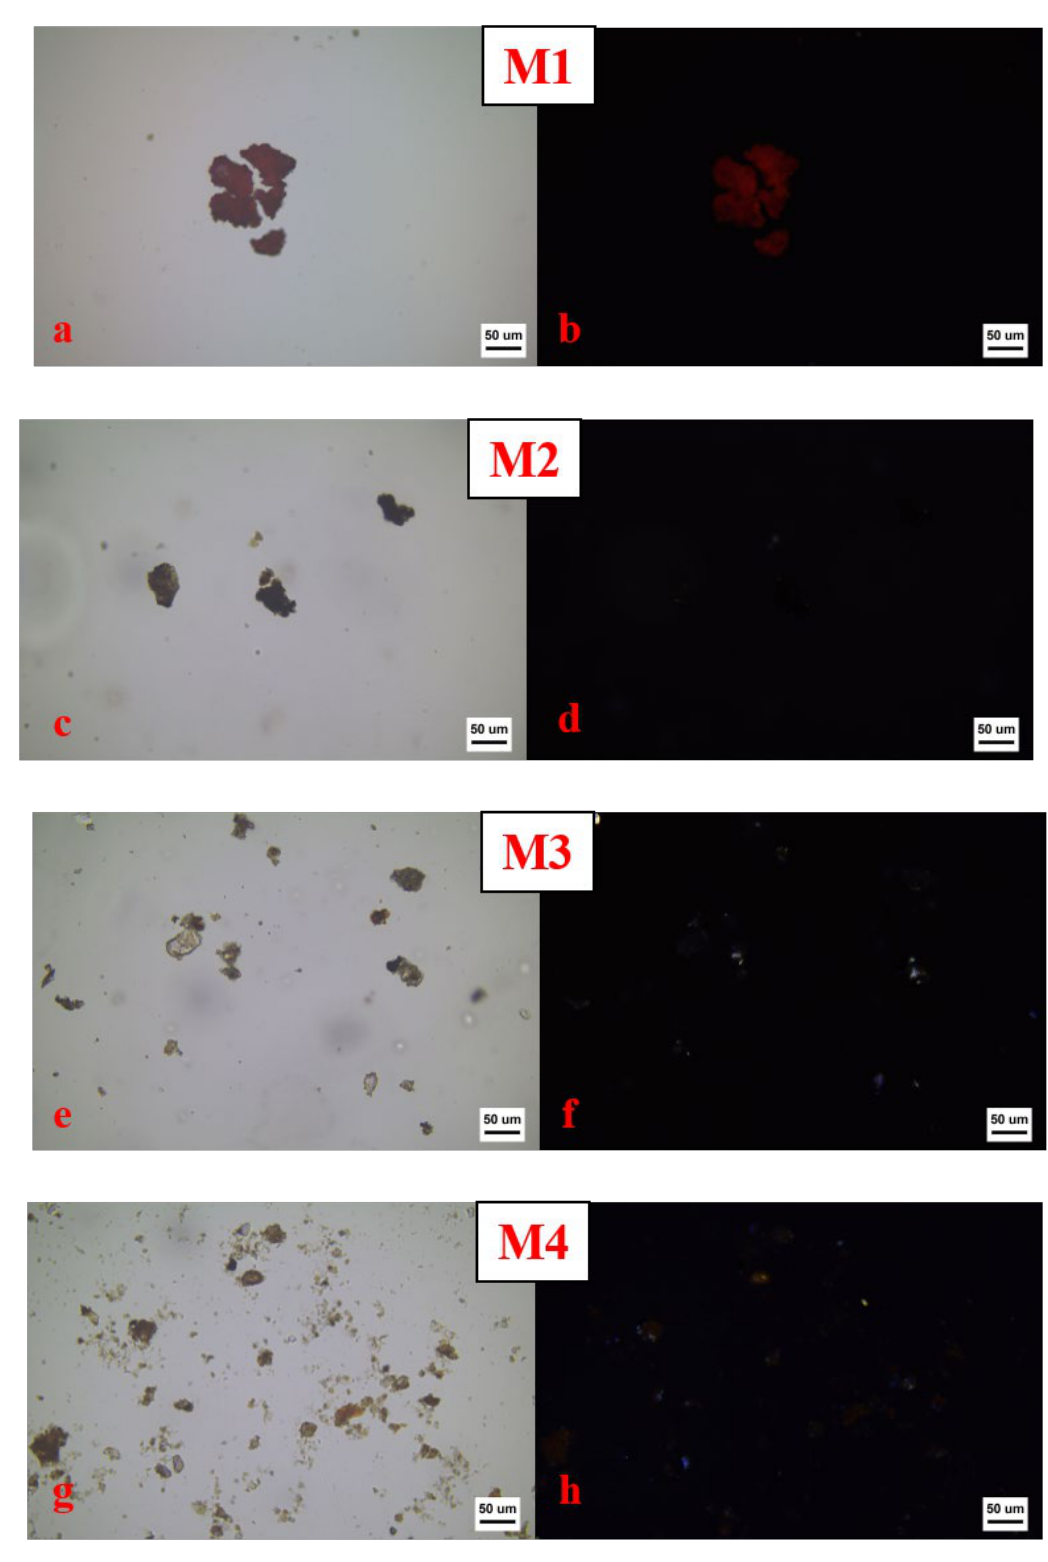
Figure 2. Pictures of horizontal polarized light ( a , c , e , g ) and perpendicular polarized light ( b , d , f , h ). PLM image of red pigment (M1), black pigment (M2), white pigment (M3) and red-2 pigment (M4).